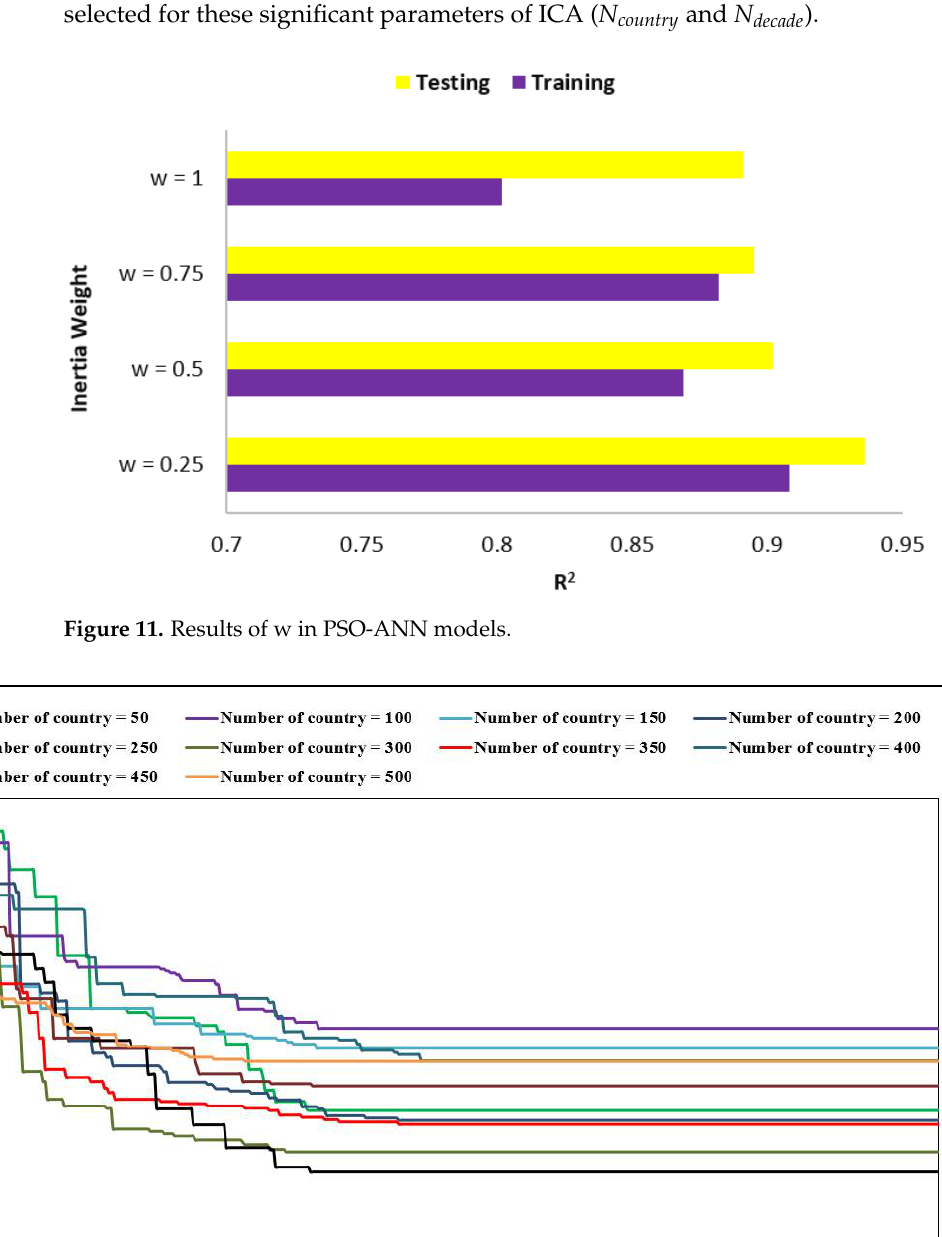
Figure 10. C 1 and C 2 results in PSO-ANN models.